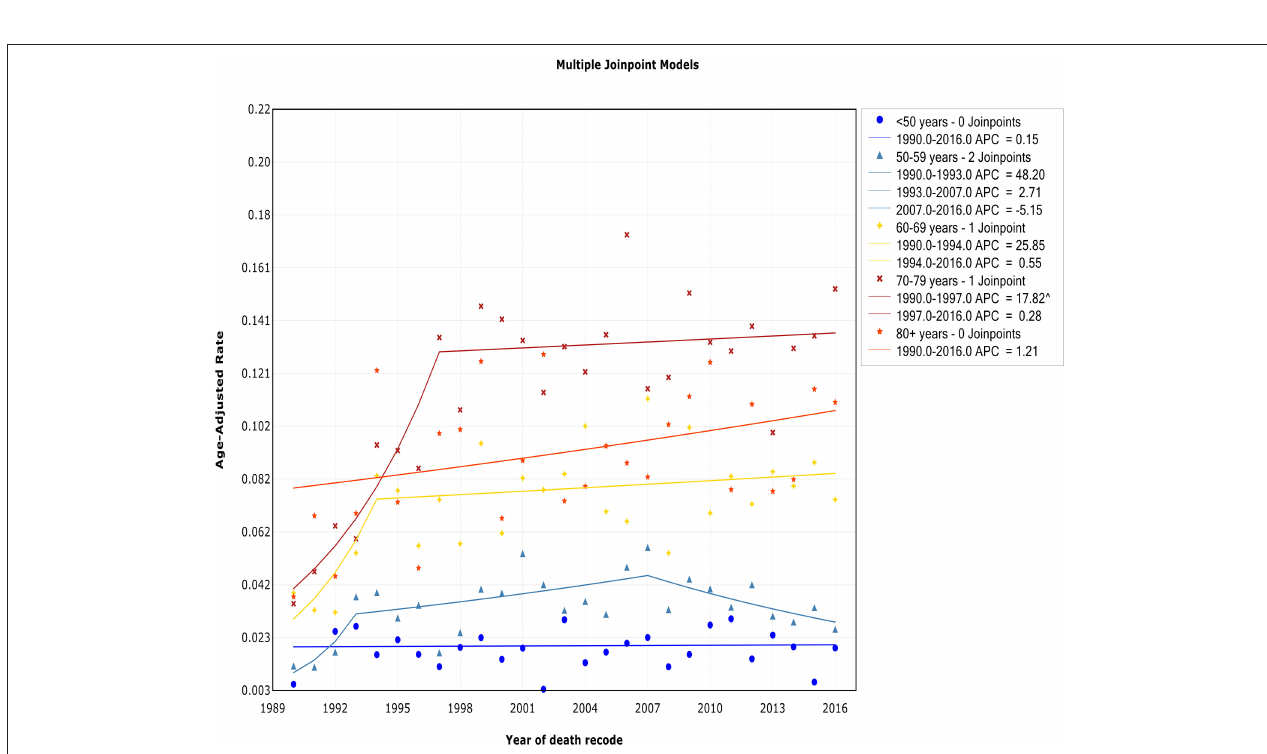
FIGURE 6 | Trends in the annual incidence-based mortality of Waldenström macroglobulinemia in patients stratified according to age.